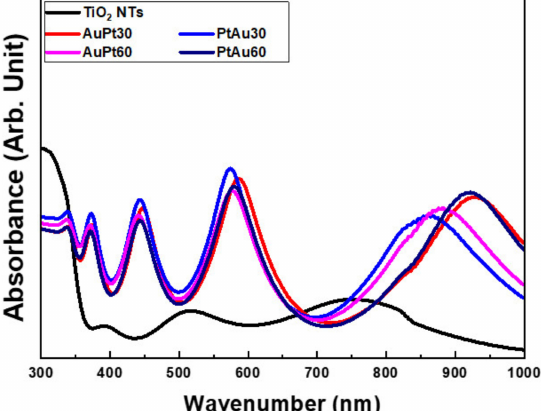
Figure 2. UV-Vis-NIR diffuse reflectance spectrophotometric curves for AuPt–TiO 2 nanotubes and PtAu–TiO 2 nanotubes after various sputtering periods (AuPt30 and AuPt60; 30 and 60 s of Au and Pt sputtering in this order, PtAu30 and PtAu60; 30 and 60 s of Pt and Au sputtering in this order, respectively).